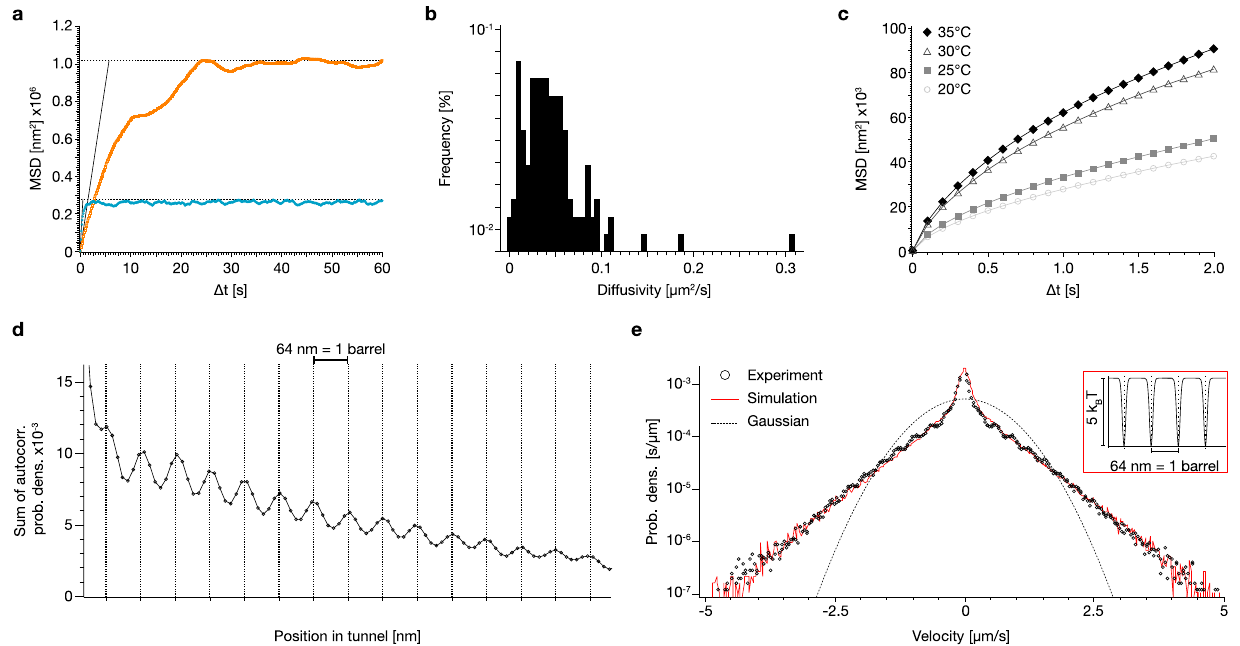
Fig. 5 MSD, track periodicity, velocity distribution. a Mean square displacement (MSD) curves of the single-particle traces in Fig. 4a, b, respectively (calculated according to Supplementary Software File 3). b Histogram of the diffusivities D of N = 128 particles. c Symbols: Mean MSD as a function of time intervals for single-particle motion, recorded at the indicated temperatures. 20 °C: N = 28, 25 °C: N = 32, 30 °C: N = 37, 35 °C: N = 31. d Sum of the spatial autocorrelation computed for N = 128 particles. e Circles: velocity distributions computed from the time-derivative of single-particle position-time traces. Dotted line: Gaussian distribution. Red solid line: velocity distribution simulated using Langevin dynamics (calculated according to Supplementary Software Files 1 and 2). Inset: free energy surface used in the